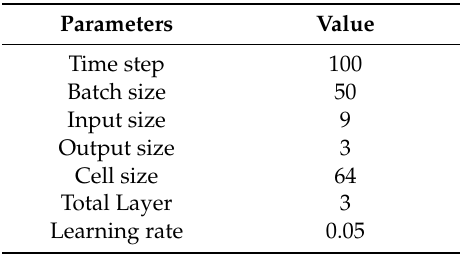
Table 1. Hyper-Parameters of LSTM Network.